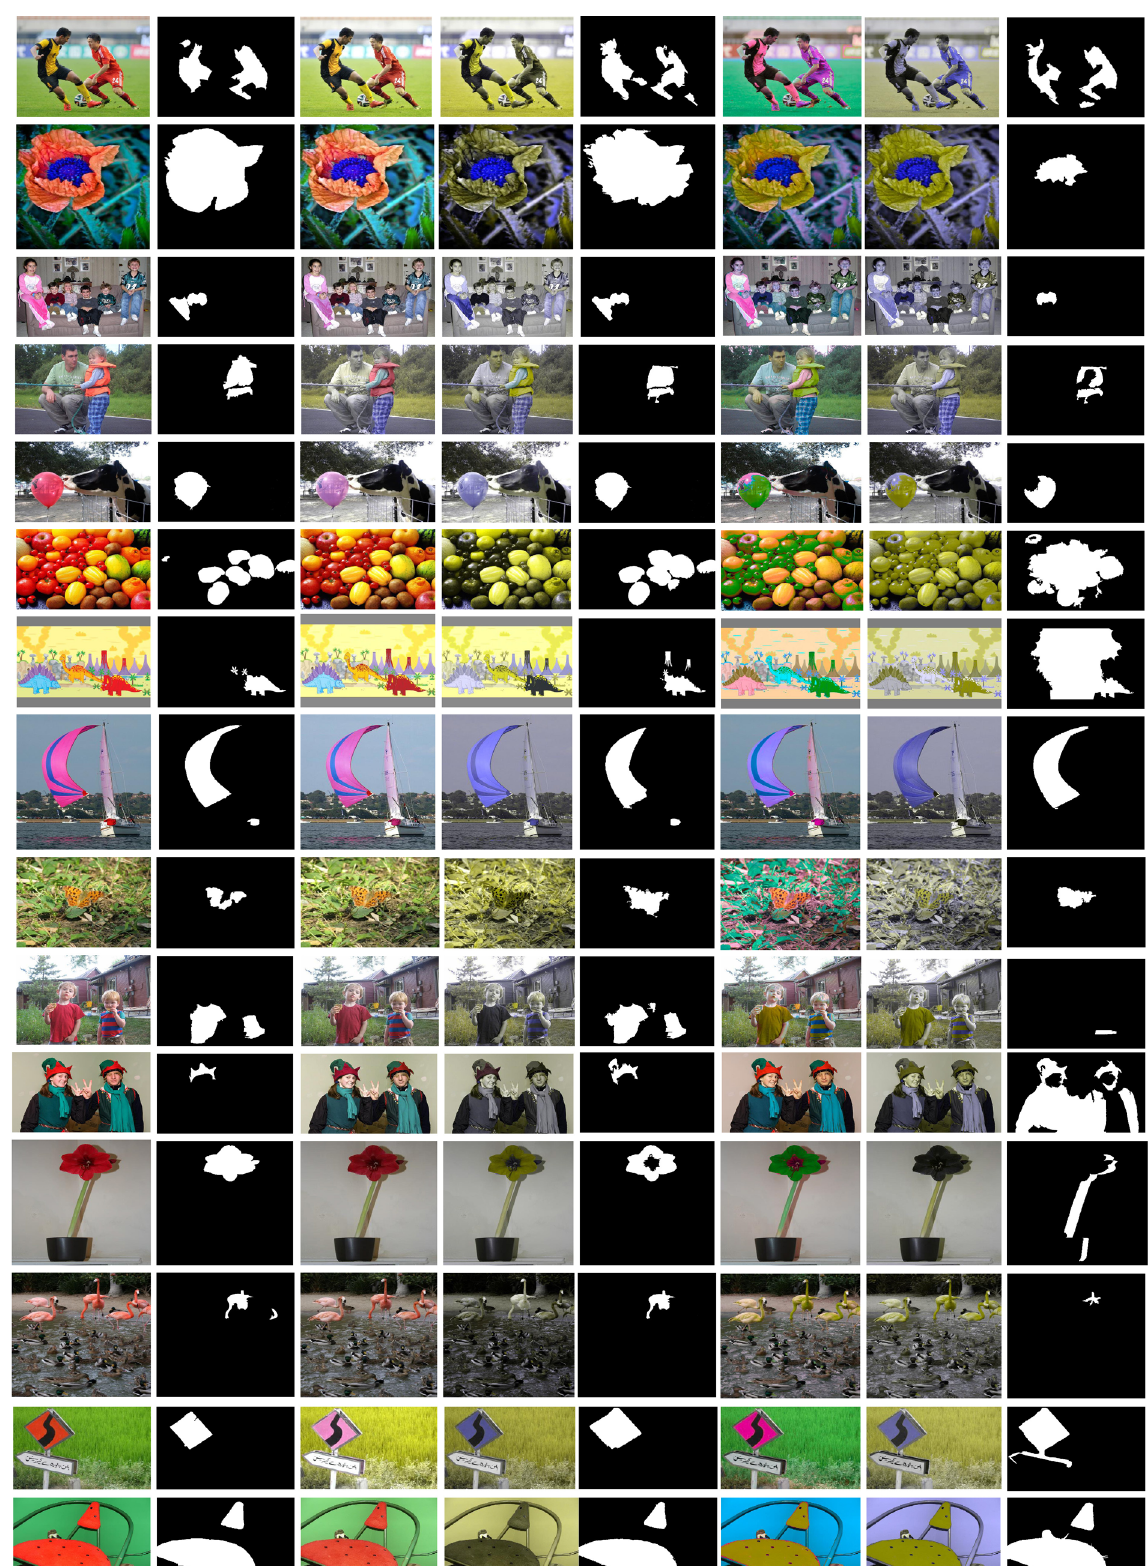
Fig. 10 For the protanopia image, compare our method with Huang’s color correction